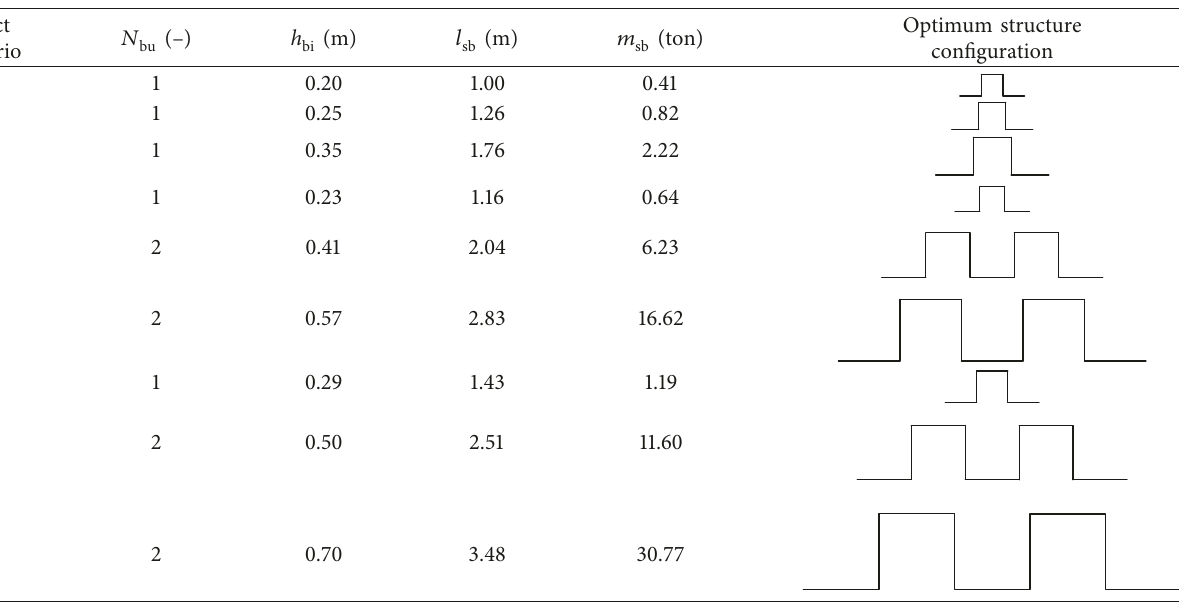
Table 5: Optimum parameters, total masses of beam steel, and configurations of optimum devices corresponding to different impact scenarios.